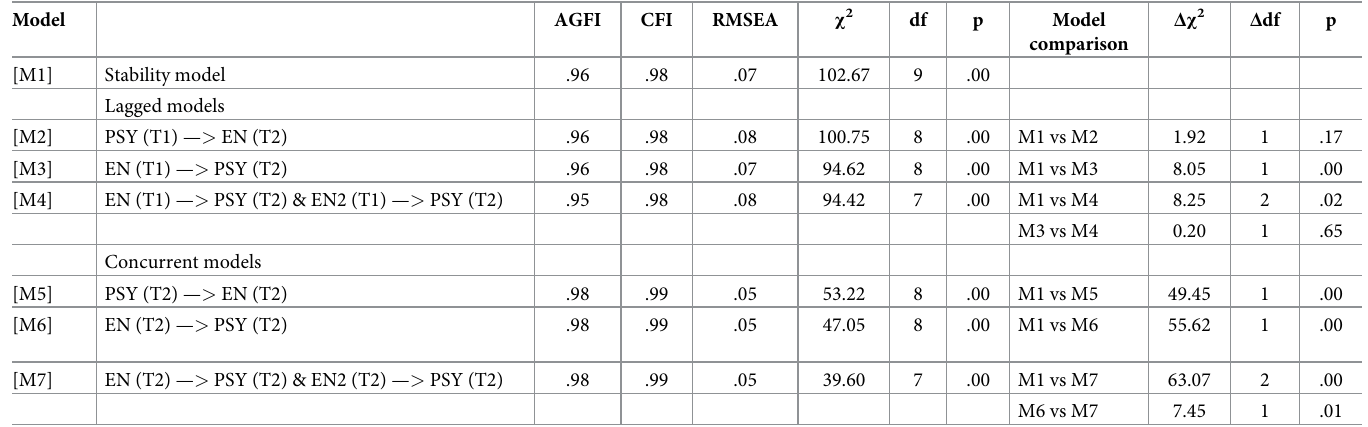
Table 2. Longitudinal relations between work engagement and psychological distress (N = 1,967).